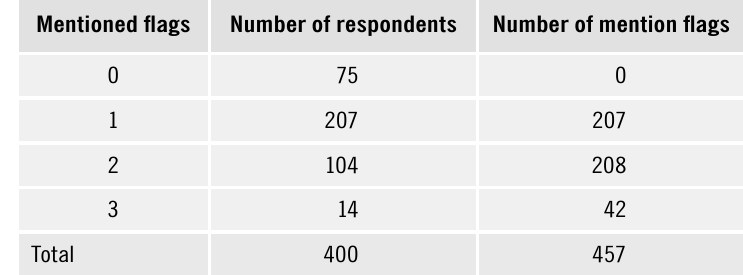
Table 3. Distribution of respondents’ mention flags